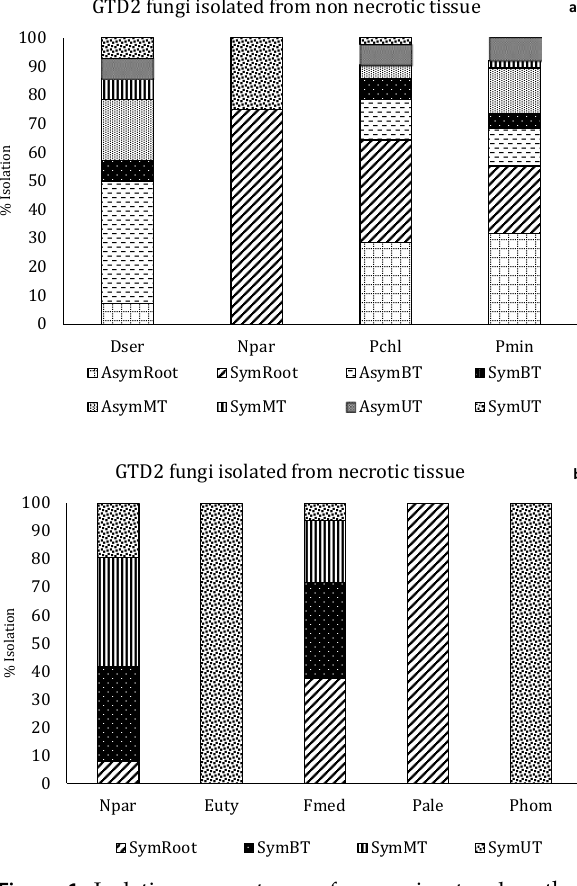
Figure 1. Isolation percentages of grapevine trunk patho- gens from non-necrotic host tissues (a) and necrotic tissues (b) of 30-year-old ‘Cabernet Sauvignon’ grapevines in NE Spain. Data are from asymptomatic (Asym) and symp- tomactic (Sym) plants, and from different plant parts (roots, basal trunks (BT), medium trunks (MT) and upper trunks (UT)). Values are expressed as percentages to the total num- ber of reisolations of fungal species. There is no data for Eu- typa cf. lata (Euty), F. mediterranea (Fmed) and Phomopsis sp. (Phom) in a, and for D. seriata (Dser) and P. chlamydospora (Pchl) in b. N. parvum (Npar) and P. minimum (Pmin) are represented in both